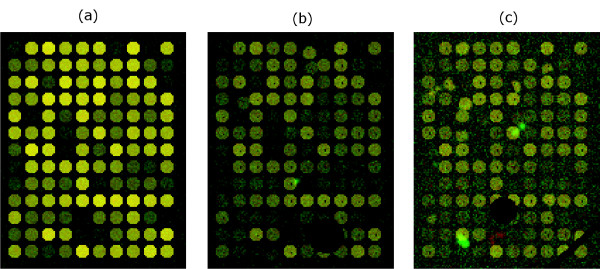
Slide image segmentation examples. One subarray from each of the images used to test the segmentation algorithms are shown. From left to right: (a) high quality slide, (b) noisy slide with artifacts, and (c) disturbing noise and artifacts over the slide. Increase in noise and degradation of the spot quality is clearly observable.